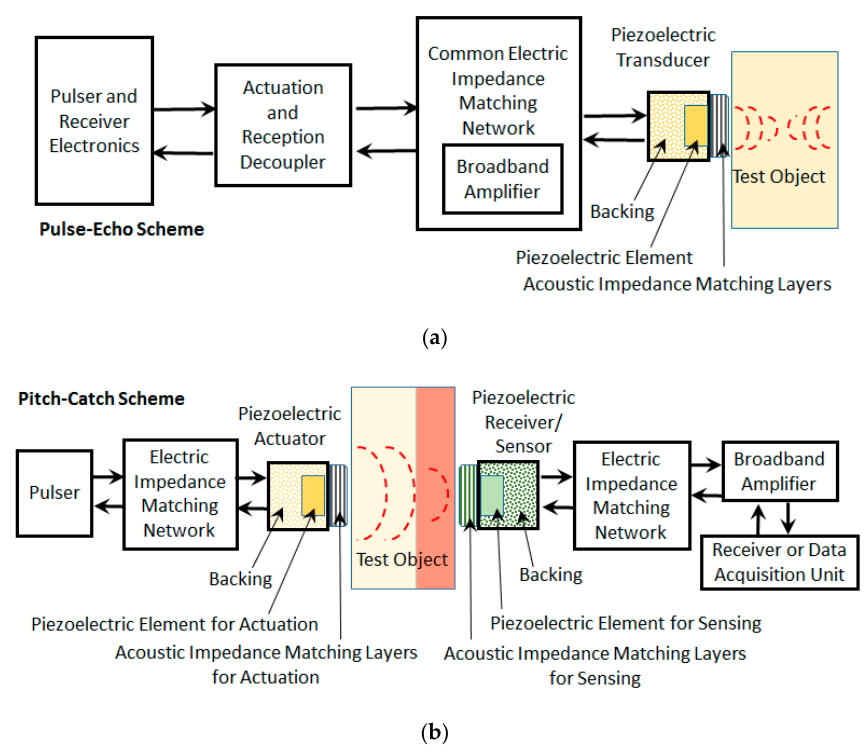
Figure 1. Schematic of elements involved in the acoustic and electric impedance matching ( a ) for a pulse–echo mode where the same piezoelectric element is used both as actuator and sensor i.e., transducer with same acoustic matching layers, backing material, and electric impedance matching network, and ( b ) for a pitch–catch mode where the different piezoelectric elements are used as an actuator and sensor with different electric impedance matching networks, backing material, and acoustic matching layers.